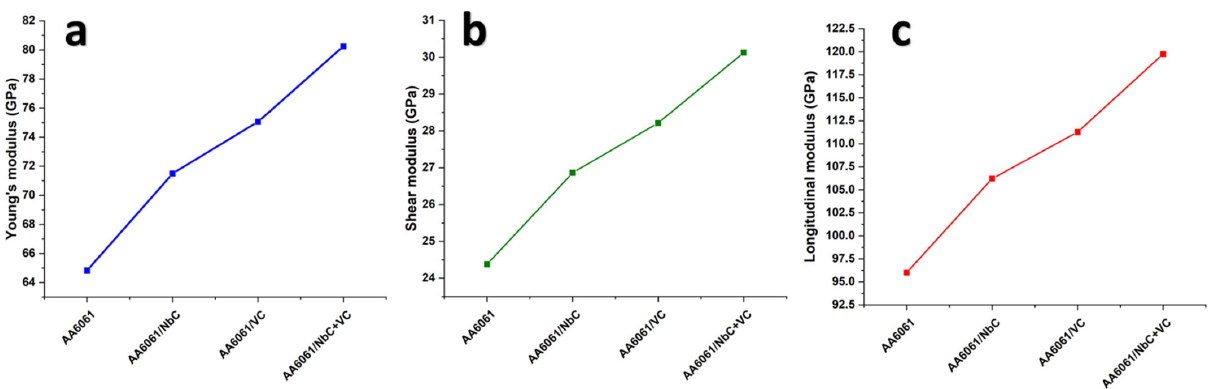
Figure 8. Mechanical properties of the composite samples using ultrasonic measurement ( a ) Young’s modulus, ( b ) shear modulus, ( c ) longitudinal modulus.